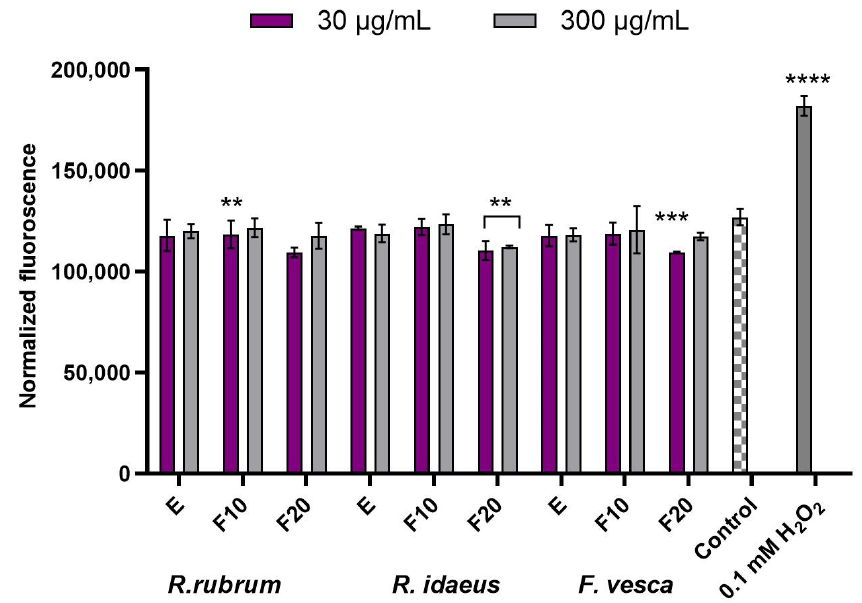
Figure 2. Effect of R. rubrum, R. idaeus , and F. vesca extracts and kombucha ferments (at concentrations of 30 µ g/mL and 300 µ g/mL) on the DCF fluorescence in fibroblasts (BJ). Data are the mean ± SD of three independent experiments. **** p < 0.0001, *** p < 0.001, ** p < 0.01 compared to the control.